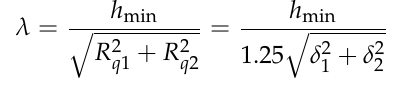
Figure 12. Journal position status at different speeds: ( a ) Axis position and ( b ) Eccentricity and eccentricity angle.